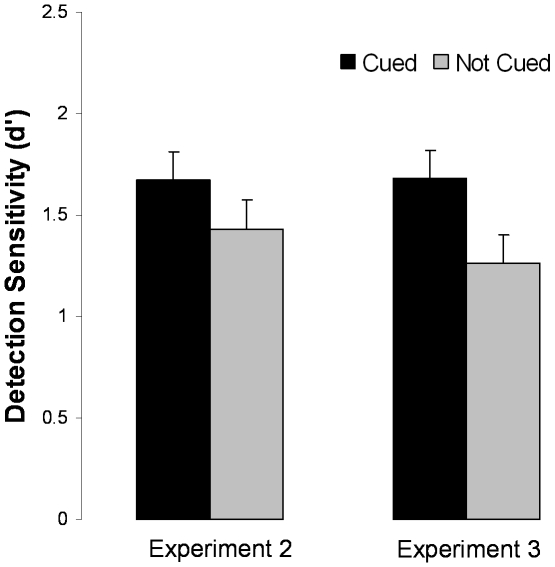
Results from Experiment 2.Bars indicate ±1 SE of the within-subject difference in the means. Asterisks indicate significant differences between condition means at p<.05.